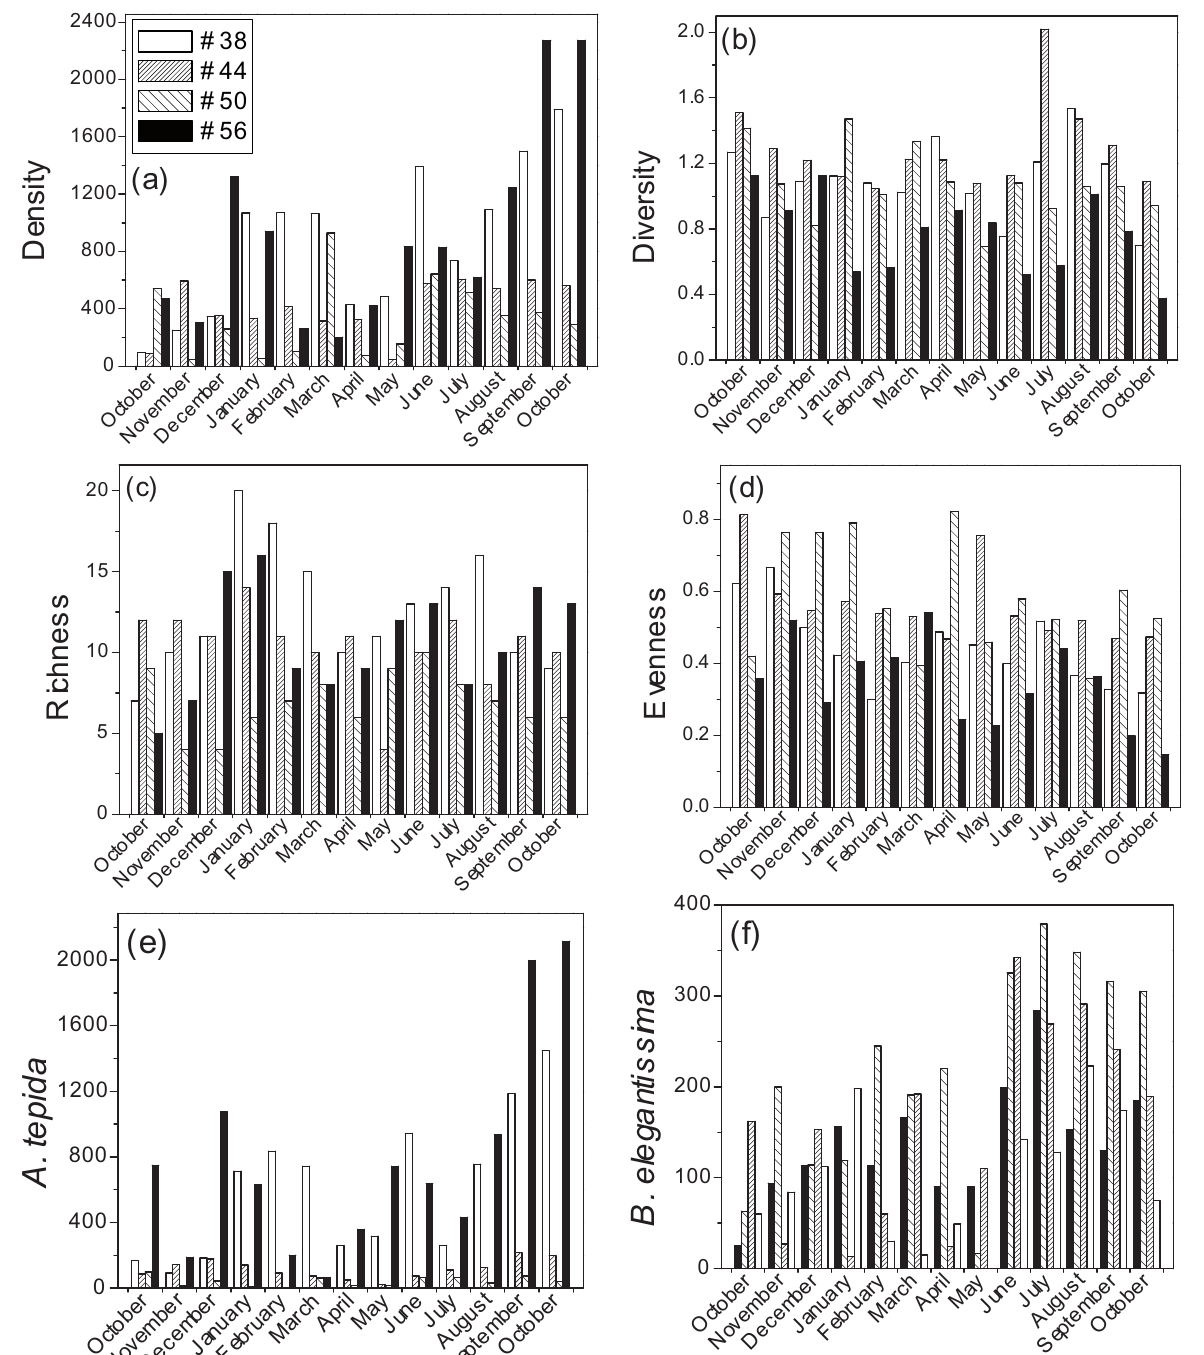
F IG . 6. – Time distribution of the population parameters for the four analysed stations. (a) Density; (b) Diversity; (c) Richness, (d) Evenness (e) Ammonia tepida density and (f) Buliminella elegantissima density. Legend is shown in (a). ips: individual per sample in a volume sample of 230 cm 3